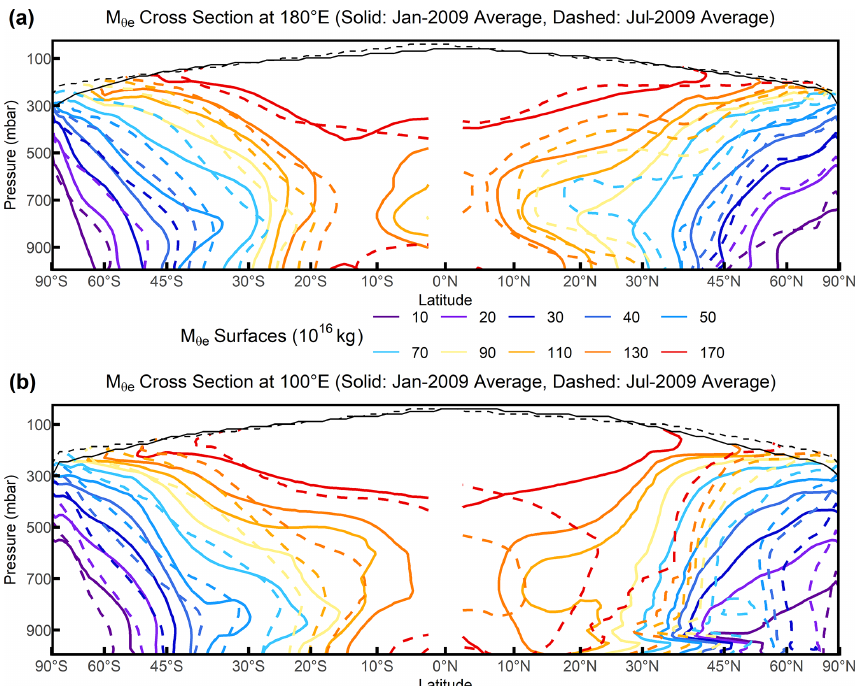
Figure 3. M θ surfaces as January 2009 average (solid lines) and July 2009 average (dashed lines) for (a) 180 ◦ E (mostly over the Pacific e Ocean), and (b) 100 ◦ E (mostly over the Eurasia land in the Northern Hemisphere). M θ